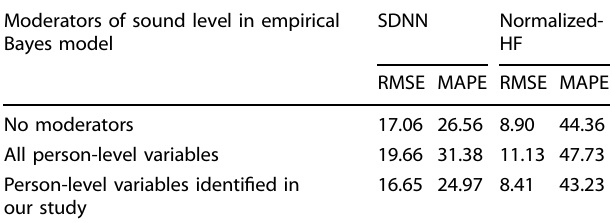
Table 5. Performance comparison of models with different set of person-level factors as